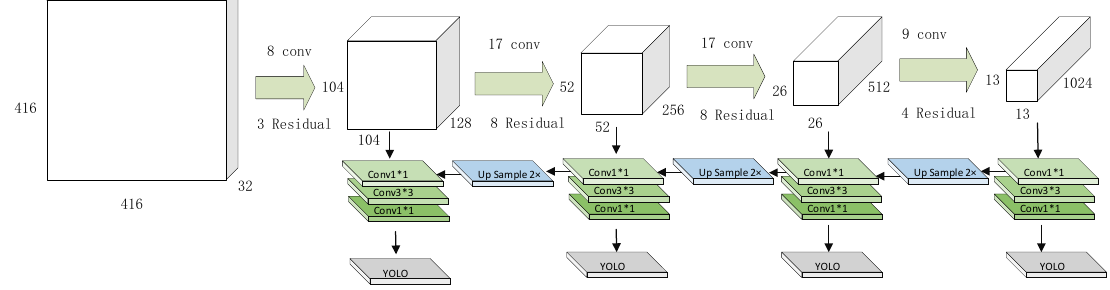
Figure 2. Improved YOLOV3 network structure of the prediction layer.